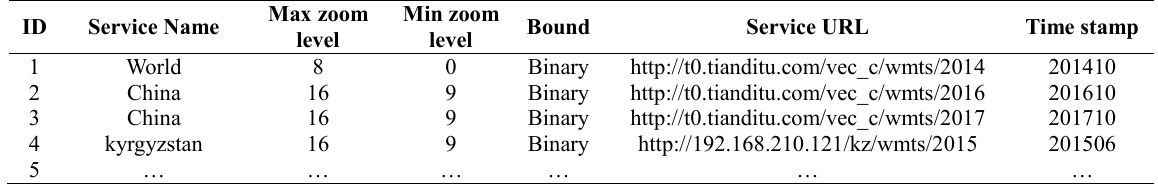
Table 1. Sample metadata table of services